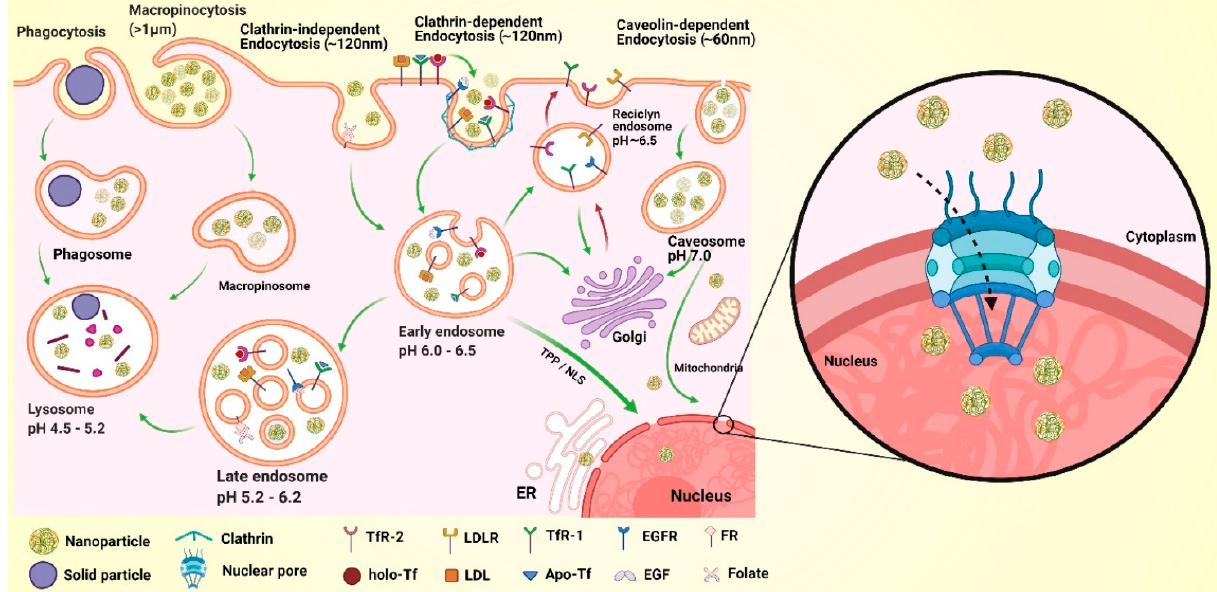
Figure 6. Receptor-mediated endocytosis. Macropinocytosis forms macropinosomes that in turn generate early endosomes. Clathrin-mediated endocytosis (CME) and caveolin-mediated endocytosis (CVME) are the main receptor-mediated endocytosis (RME) mechanisms. Additional endocytic mechanisms have been described, including those mediated by flotillin, ARF6, RhoA and CDC42. In neurologic tissues, CME is the predominant mechanism of endocytosis. The final fate of endosome and endosome-like vesicles is to fuse with lysosomes. Thus, endosome-containing NPs need to escape from lysosomes to deliver the molecular tools within the nucleus.